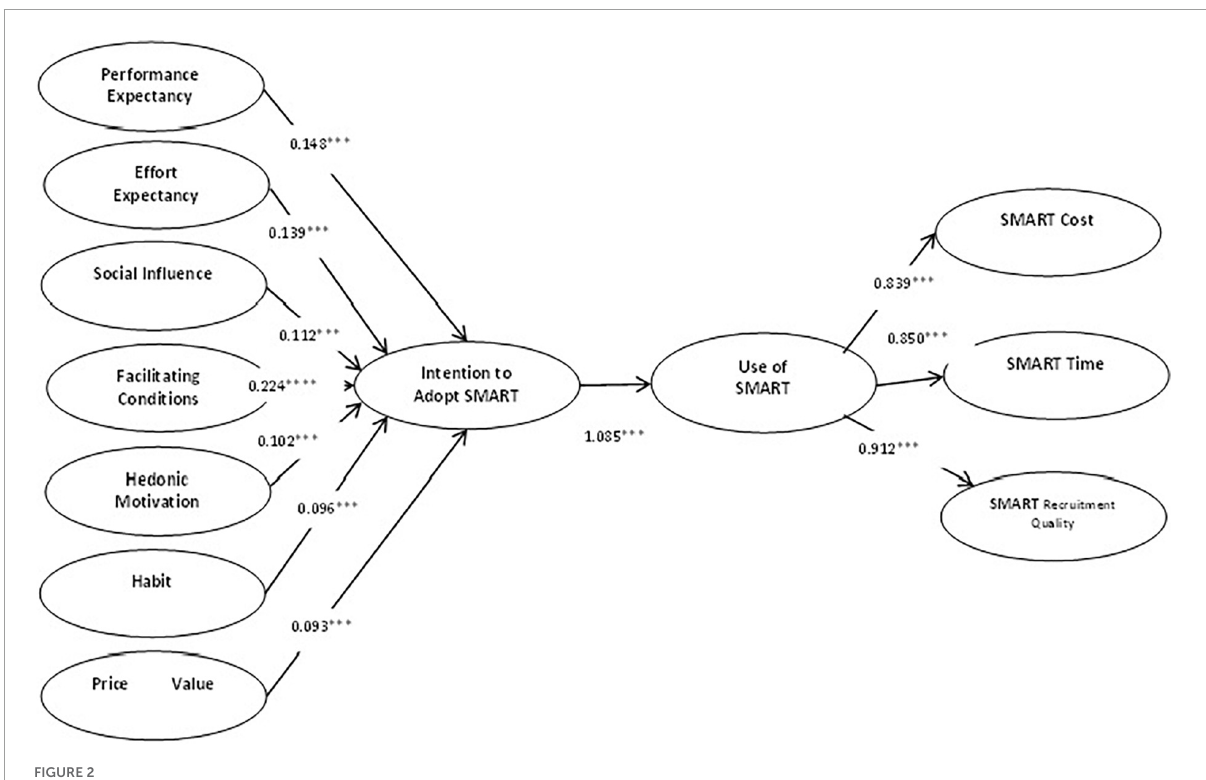
FIGURE2 The structural model with path